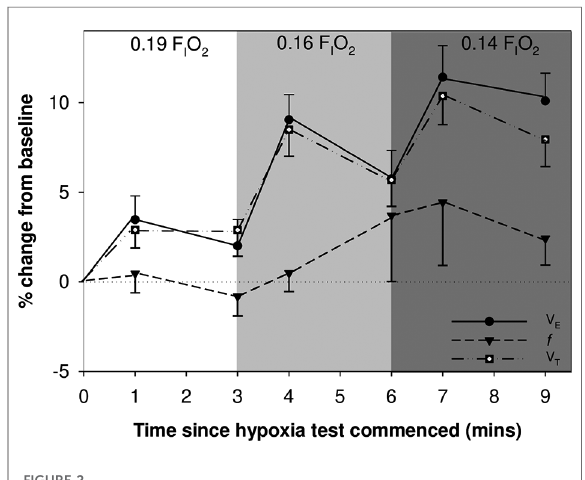
FIGURE 2 Mean (SEM) change in minute ventilation ( V E ), tidal volume ( V T ) and respiratory rate ( f ) are shown over time during the hypoxia challenge.